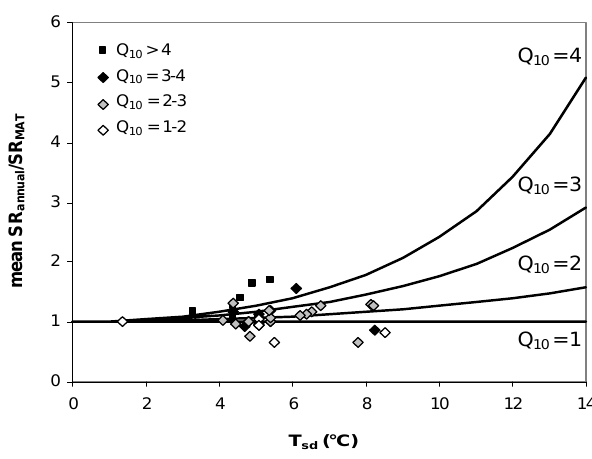
Fig. 1. The ratio of mean annual soil respiration (mean SR annual , µmolm − 2 s − 1 ) over soil respiration at mean annual temperature (SR MAT , µmolm − 2 s − 1 ) as affected by the annual variation of soil temperature ( T sd ) and Q 10 of the temperature – soil respiration re- lationship. Data points indicate values of the non water-limited sites for mean SR annual /SR MAT , T sd and Q 10